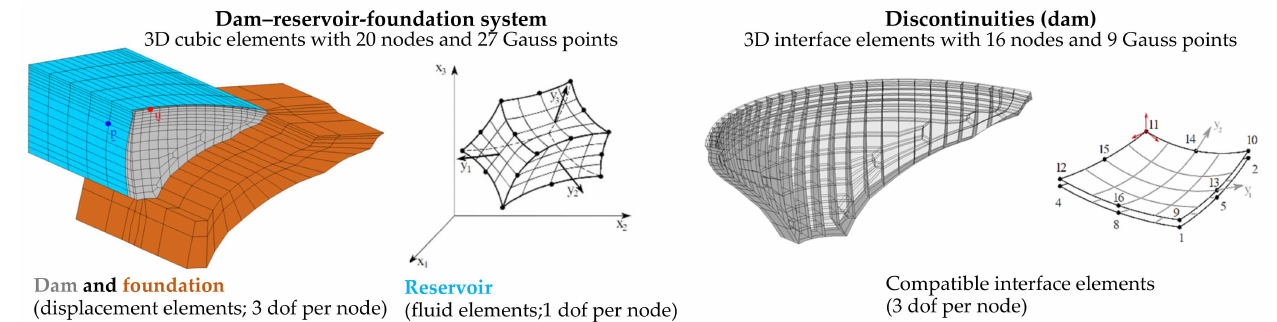
Figure 5. Types of finite elements used for discretization of the dam–reservoir-foundation system and of dam